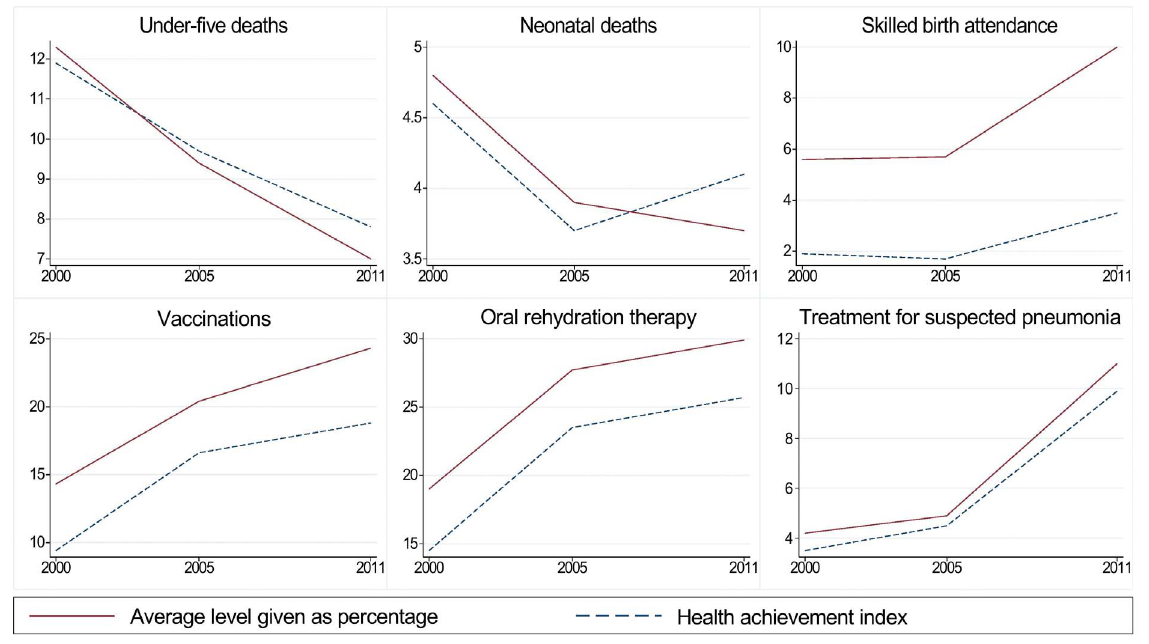
Figure 3. Changes in average level (given as percentage) and health achievement index from 2000 to 2011. Change from 2000 to 2011 in average level and health achievement index for each of the indicators. The time is on the x-axis, and the health achievement index and average level or coverage are on the y-axis.